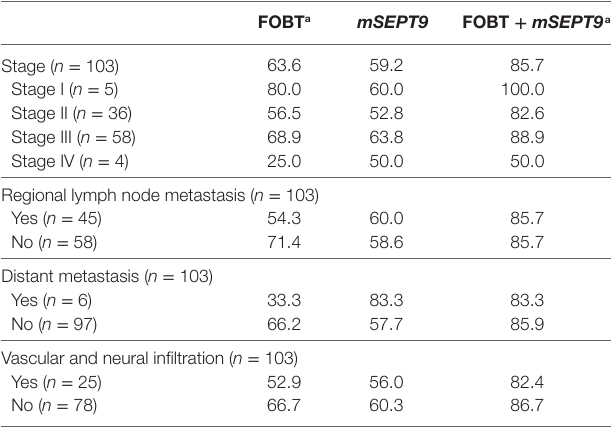
TaBle 5 | Detection sensitivity of fecal occult blood test (FOBT), mSEPT9 , and the combination for the stratification by tumor stage and metastasis (%). FOBT